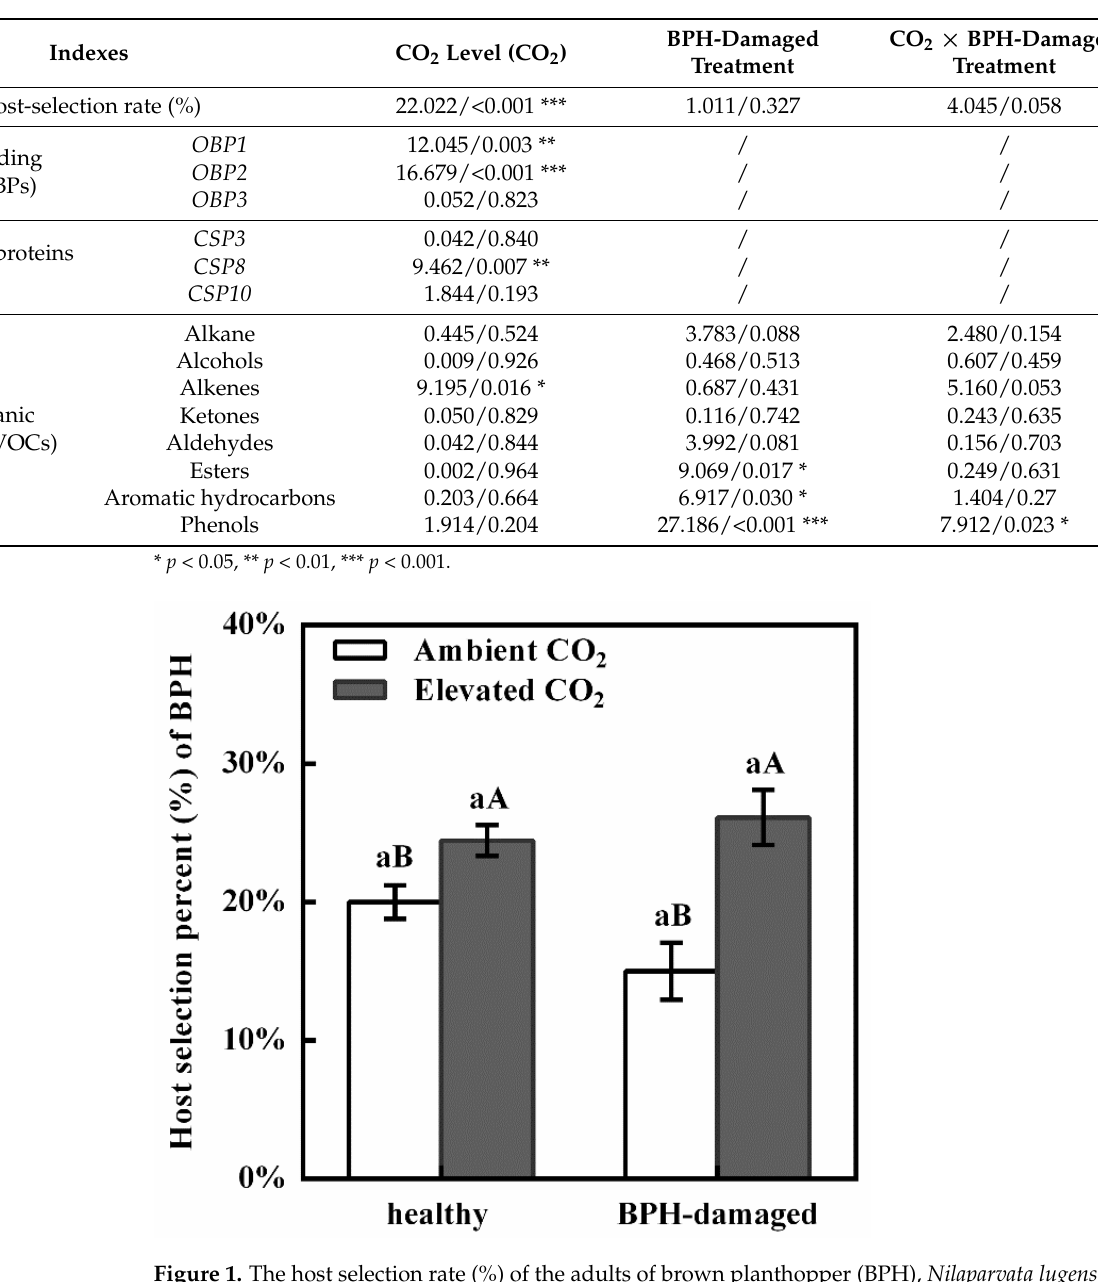
Table 2. Two-way ANOVAs on the effects of CO 2 level (ambient CO 2 versus elevated CO 2 ), damaged treatment (no damage (i.e., healthy) rice plants versus BPH-damaged rice plants) and their interaction on the host-selection rate of brown planthopper (BPH) N. lugens , and on the percent of eight groups of volatile organic compounds (VOCs) from the healthy (CK) and BPH-damaged rice plants grown under ambient and elevated CO 2 ; and one-way ANOVA on the effects of the CO 2 level on the transcript expression of OBP and CSP genes of N. lugens adults fed on rice plants grown under ambient and elevated CO 2 ( F/p values).